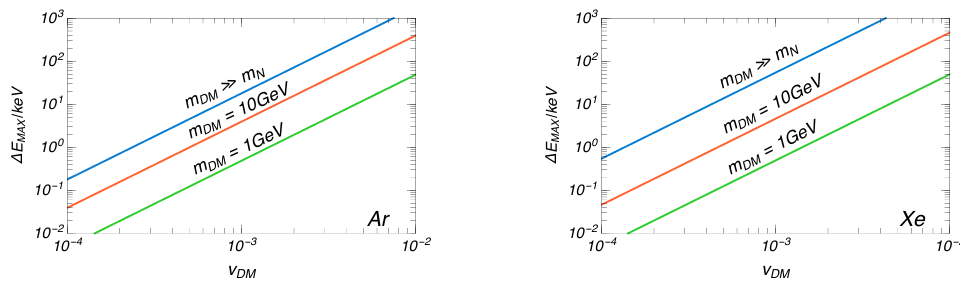
Figure 3 . The kinematical upper limits on the electron transition energy, (cid:1)E , as a function of the speed of dark matter for a given m DM . In the solar rest frame, typical dark matter velocities are of 500 km/s with an upper limit of around 700